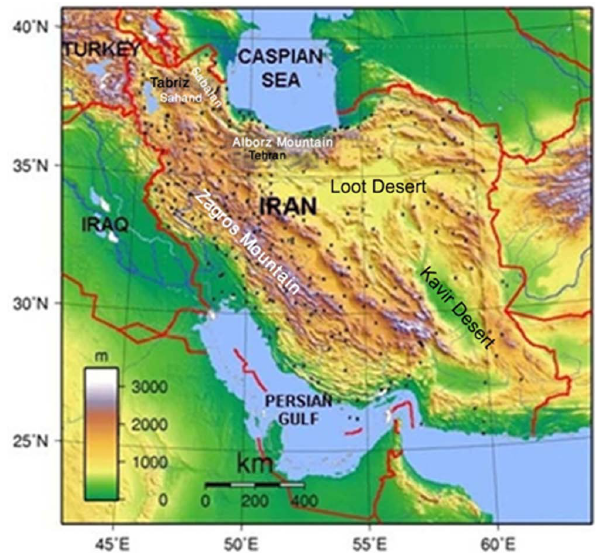
Table 1. Parameterization of WRF model configuration.